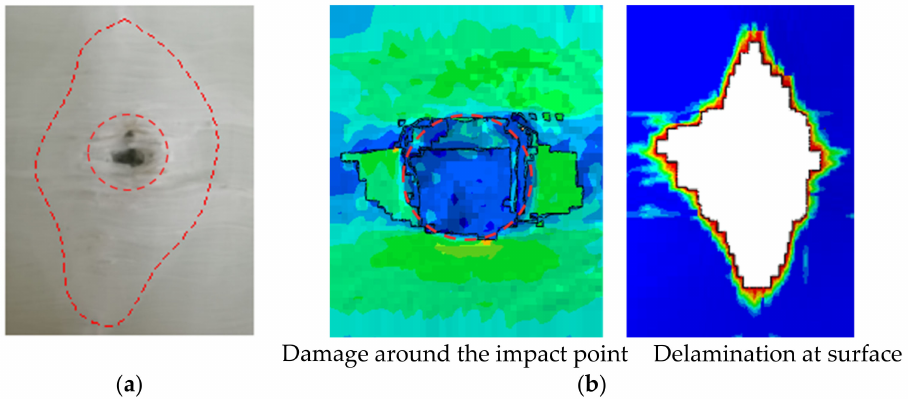
Figure 10. Comparison between the ( a ) experiment and ( b ) simulation of the damage